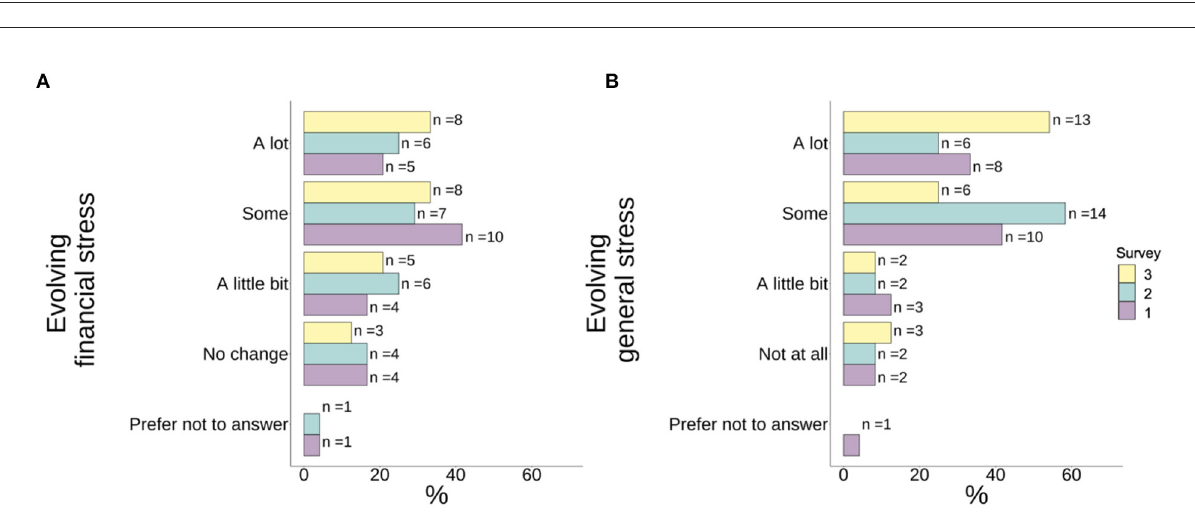
FIGURE5 Civic scientists’ evolving: (A) financial and (B) general